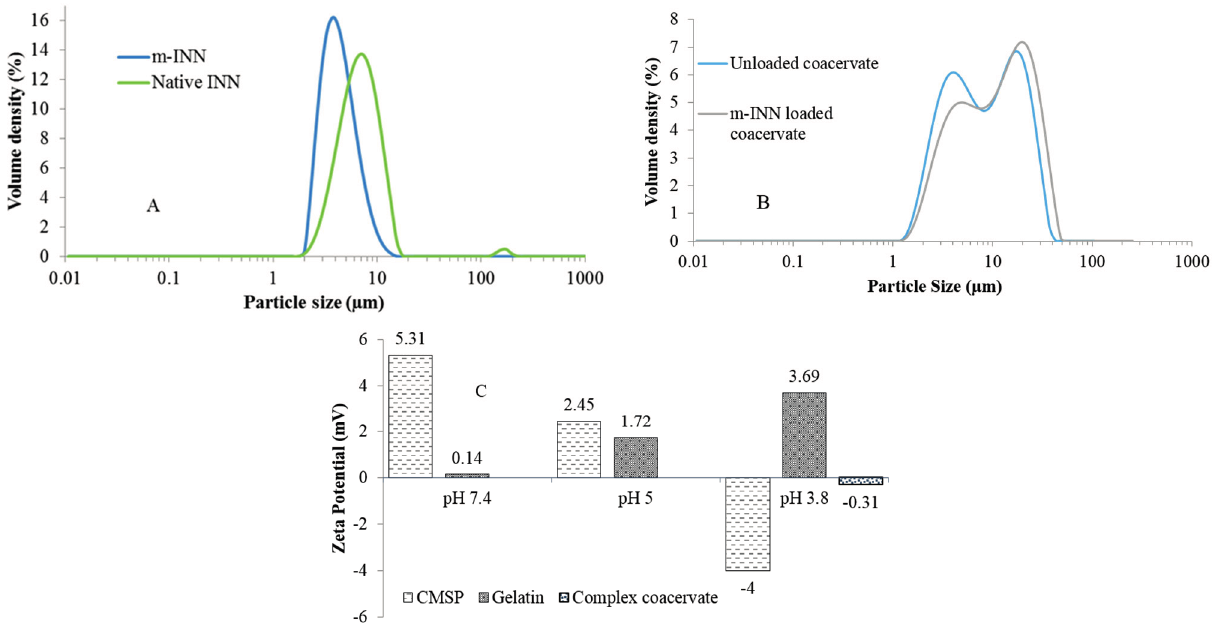
Figure 1. ( A ) Particle size distribution (log scale) of native and micronized ibuprofen (INN); ( B ) The size distribution (log scale) of unloaded and drug loaded coacervates; and ( C ) The zeta potential of CMSP, gelatine and complex